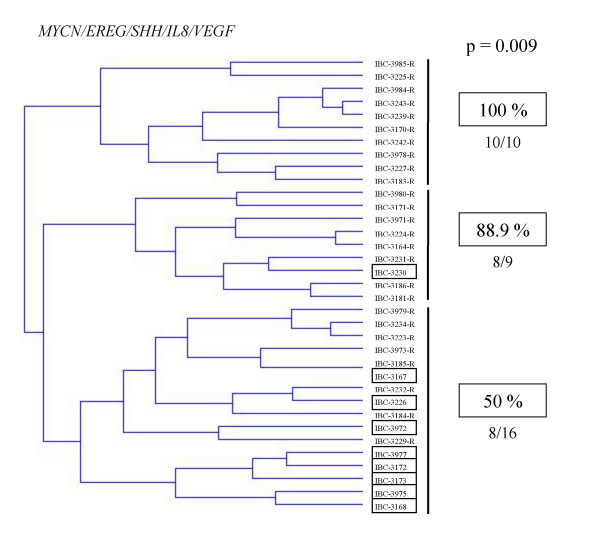
Dendrogram of 26 IBCs who relapsed (R) and 9 who did not relapse (circled) constructed by hierarchical clustering, according to MYCN/EREG/SHH/IL8/VEGF expression. The percentage of patients who relapsed are indicated on the right.